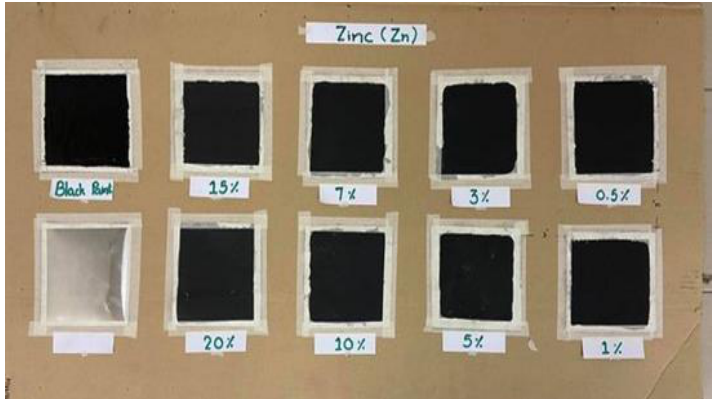
Figure 1. Arrangement of samples.